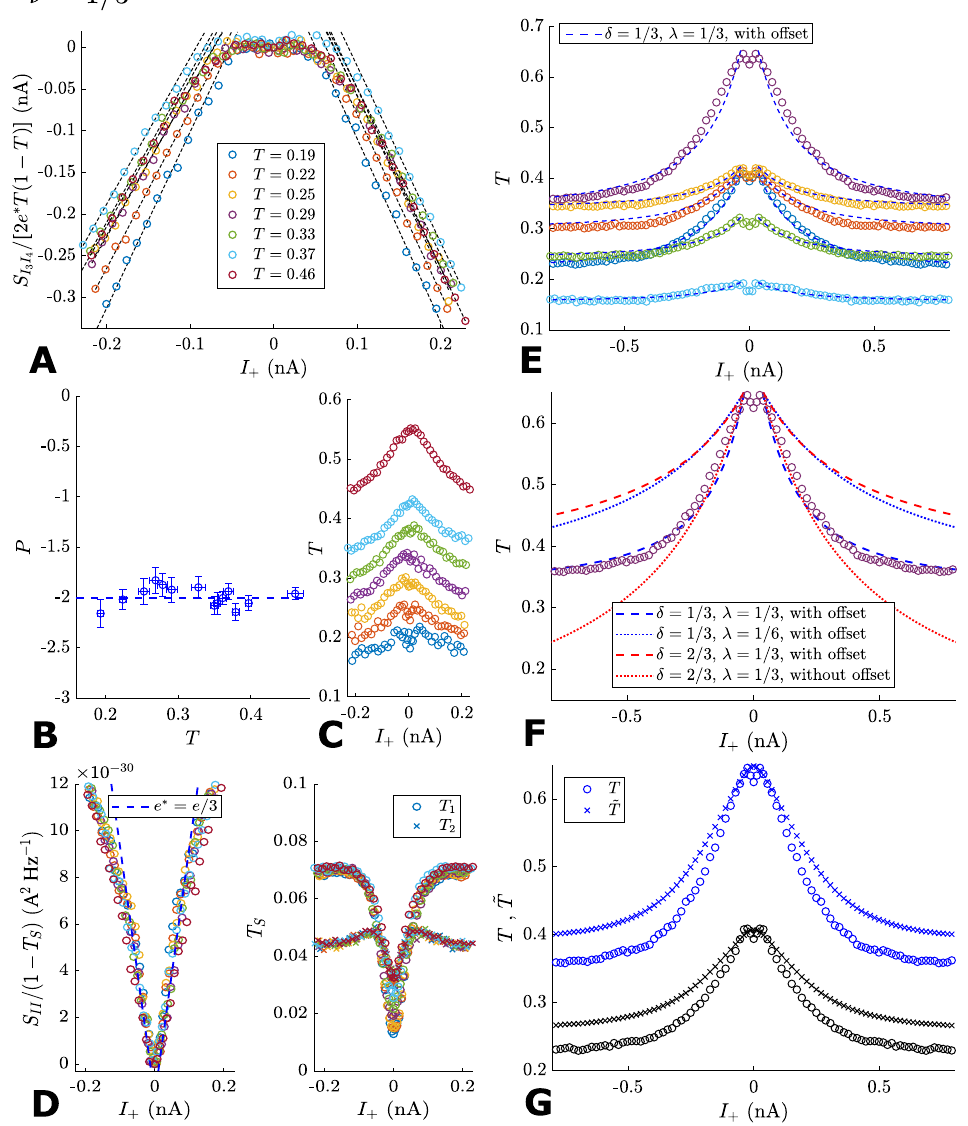
FIG. 3. Balanced collider at ν ¼ 1 = 3 . (a) S 34 = ½ 2 e (cid:2) T ð 1 − T Þ(cid:4) , with e (cid:2) ¼ e= 3 as a function of I þ for different values of T [plotted in (c)]. The dashed lines are linear fits whose slope P is plotted in (b). (b) P [extracted from the linear fits of (a)] as a function of T . (c) Measurements of T as a function of I þ in the collision experiment. (d) Left-hand panel: S II = ð 1 − T S Þ as a function of I þ , with S ¼ S þ S þ 2 S 2 e= 3 I T T I T as a function of I II 33 44 34 . The blue dashed line is þ . Right-hand panel: 1 and 2 as a function of þ . (e) þ in a larger range of input anyon currents and for different values of CQPC gate voltage. The blue dashed lines are comparisons with Eq. (4), adding an offset of 35 pA in I þ that takes into account the thermal rounding at low I þ , and an offset T 0 in the values of T . The values of T T ¼ 0 . 21 (blue points), T ¼ 0 . 30 (red points), T ¼ 0 . 34 (yellow 0 are extracted from a fit of the experimental data (see text) with 0 0 0 points), T 0 ¼ 0 . 33 (violet points), T 0 ¼ 0 . 24 (green points), and T 0 ¼ 0 . 16 (cyan points). The other parameters for comparing data with ¼ 30 mK. (f) Comparison between data and Eq. (4) using δ ¼ λ ¼ 1 = 3 and T ¼ 0 . 33 (blue model are λ ¼ δ ¼ e (cid:2) =e ¼ 1 = 3 and T 0 el dashed line), δ ¼ 1 = 3 , λ ¼ 1 = 6 , and T 0 ¼ 0 . 33 (blue dotted line), and δ ¼ 2 = 3 , λ ¼ 1 = 3 , and T 0 ¼ 0 . 33 (red dashed line), and using ¼ 0 (red dotted line). (g) Comparisons between the evolution of T (circles) and ˜ T (crosses) with I δ ¼ 2 = 3 , λ ¼ 1 = 3 , and T 0 þ at filling factor ν ¼ 1 = 3 for two different values of CQPC gate voltage. e (cid:2) ¼ e= 3 (with some deviations around the maximum current backscattered at QPC1 and QPC2 and where the factor ð 1 − T S Þ takes into account deviations from the current of 200 pA), showing that the charge measurements are consistent with the collision data. The right-hand panel Poissonian limit (here, as T S ≈ 0 . 05 , 1 − T S ≈ 1 ). As can be of Fig. 3(d) represents the measurement of the anyon seen in Fig. 3(d), the data agree well with the anyon charge